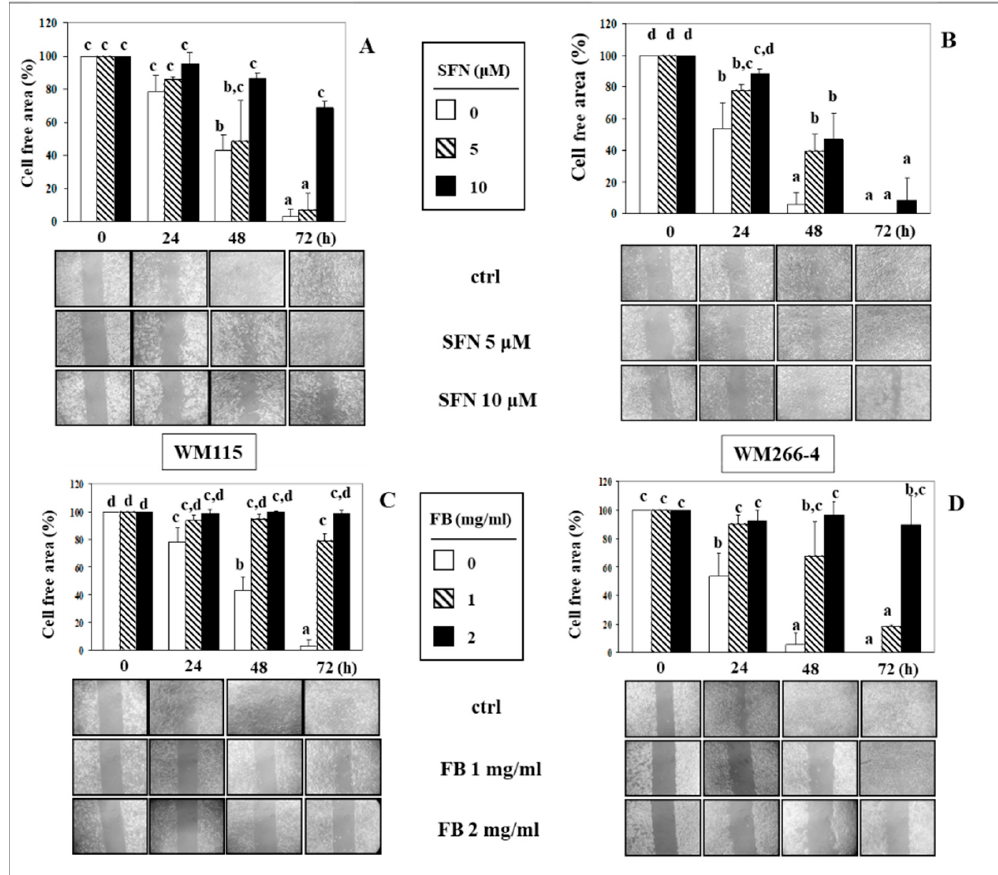
Figure 2. Effect of SFN and FB on migration ability evaluated in WM115 ( A ) and ( C ) and WM266-4 ( B ) and ( D ) melanoma cells by Wound Healing assay (see Materials and Methods section for details). Panels ( A ) and ( B ): cells were treated with SFN 5 and 10 μ M for increasing periods of time (24-72 h); panels ( C ) and ( D ): cells were treated with FB 1 and 2 mg/mL for increasing periods of time (24-72 h). Values not sharing the same superscript letter are significantly different ( p < 0.05, One-way ANOVA, followed by Tukey’s test). Below each histogram a representative Wound Healing assay of at least three different experiments is shown.